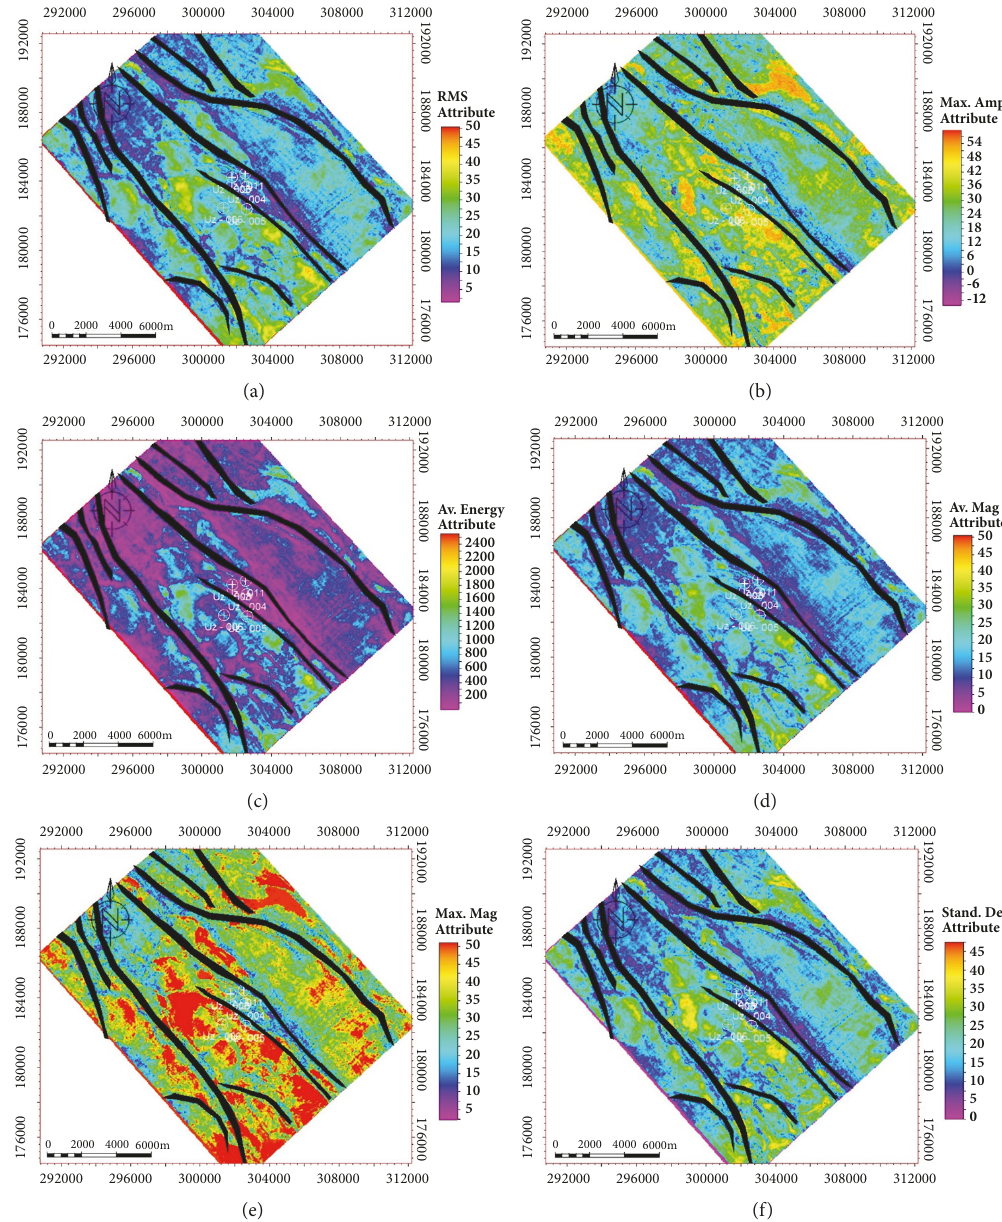
Figure 9: Generated amplitude maps D9000 reservoir top. (a) RMS amplitude Attribute map for D9000 reservoir top. (b) Maximum amplitude attribute map for D9000 reservoir top. (c) Average energy amplitude attributes for D9000 reservoir top. (d) Average magnitude amplitude attributes for D9000 reservoir top. (e) Maximum magnitude attribute map for D9000 reservoir top. (f) Standard deviation amplitude attribute map for D9000 reservoir